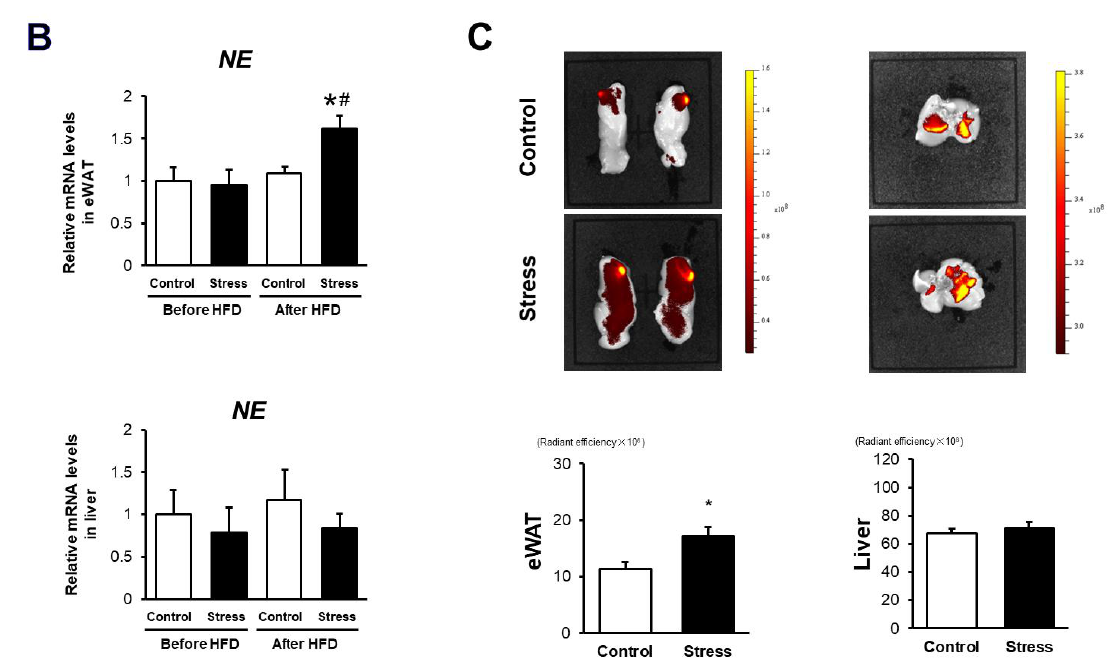
Figure 3. Neutrophil elastase (NE) activation is augmented in eWAT of stressed mice. ( A ) Immunohistochemical staining of Ly-6G/NE-double positive cells and the percentages of Ly-6G/NE-double positive cells in CLSs of eWAT. Values represent the mean ± SEM. Each group consisted of eight (Control) and eight (Stress) mice. * p < 0.05 vs. Control. Arrow indicates Ly-6G/NE-double positive cells. Scale bar = 20 µm. ( B ) Quantitative PCR analysis of NE mRNA expression levels in eWAT and liver. Values represent the mean ± SEM relative to Control. Each group consisted of 4 (Control before HFD), 4 (Stress before HFD), 10 (Control after HFD), and 9 – 10 (Stress after HFD) samples. * p < 0.05 vs. Stress before HFD, # p < 0.05 vs. Control after HFD. ( C ) Representative ex vivo images of eWAT and liver as well as quantitative measurement of radiant efficiency corresponding to NE activity. Values represent the mean ± SEM. Each group consisted of 10 (Control) and 10 (Stress) mice. * p < 0.05 vs. Control. Control, unstressed control mice; Stress, stressed mice; eWAT, epididymal white adipose tissue; HFD, high-fat diet.